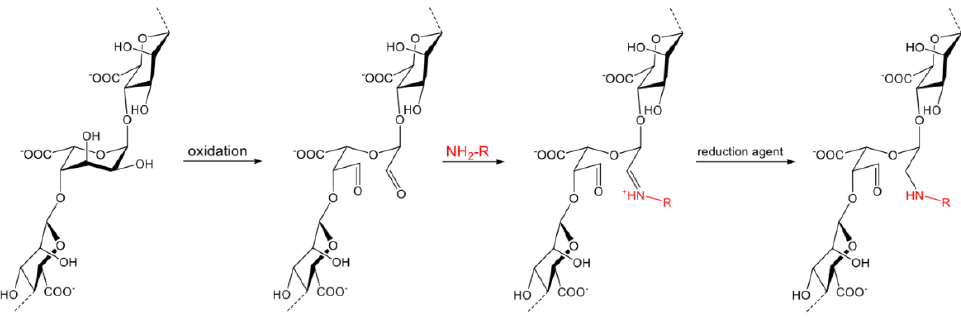
Figure 7. The general procedure of oxidation of alginate and reductive amination [67] .